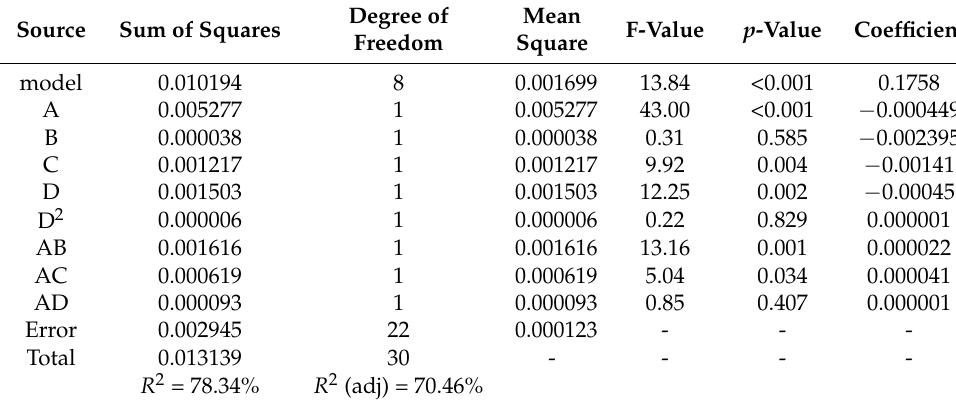
Table 8. The ANOVA of the reduced regression model for gap clearance (GC) of EDM with multi- aperture